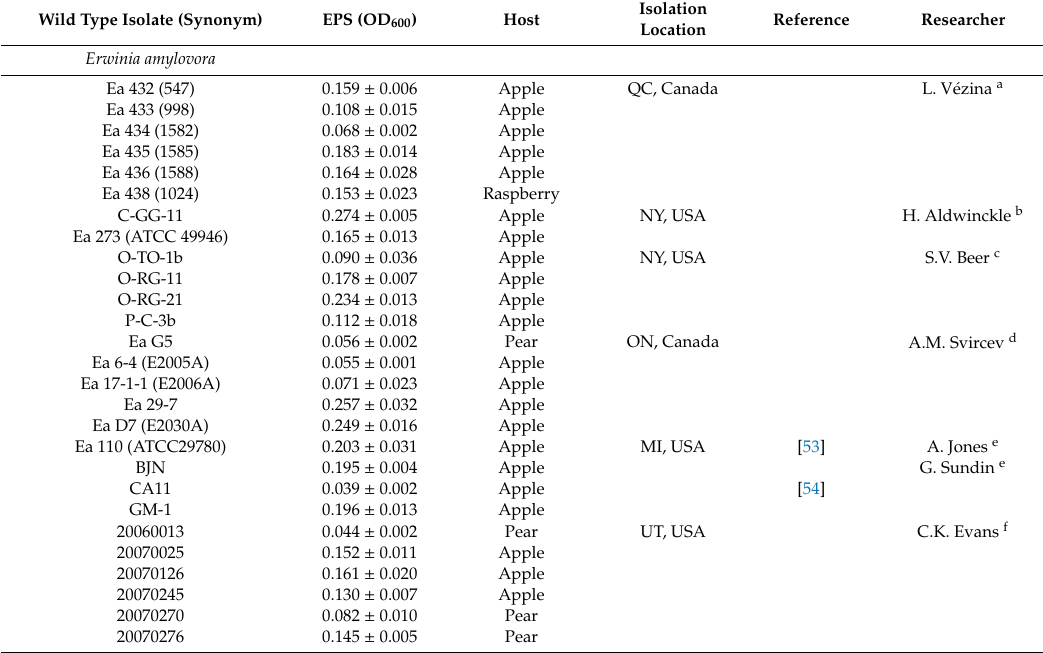
Table 1. Wild type isolates of Erwinia amylovora and Erwinia pyrifoliae used in the study. Relative EPS (amylovoran) production, plant host, location of isolation, and researcher sources of these isolates are given when known. Alternative names, or synonyms, were given in brackets when known. EPS values are OD 600 measurements and are therefore only relative and range from